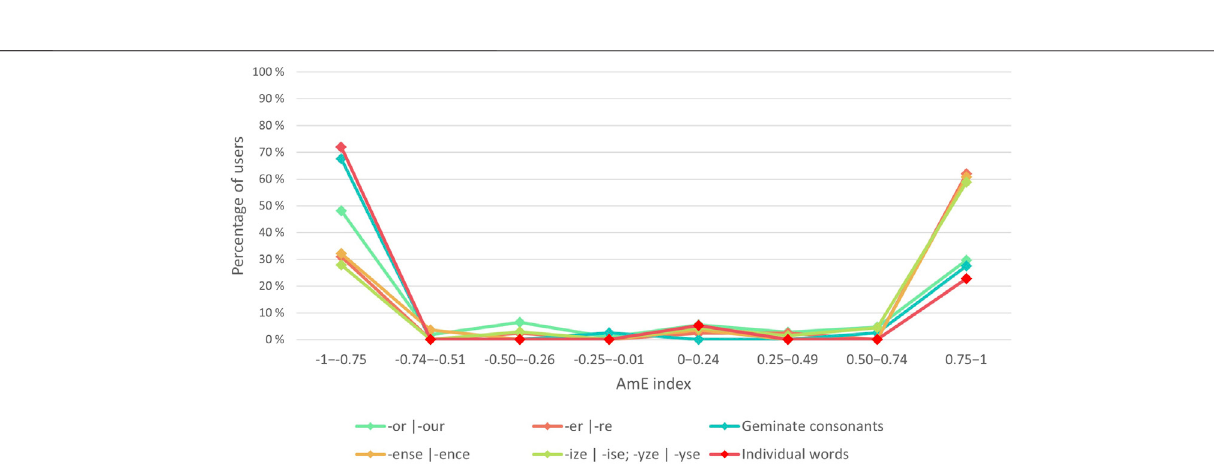
FIGURE 6 | The distribution of users ’ AmE indexes at the level of individual spelling variables.